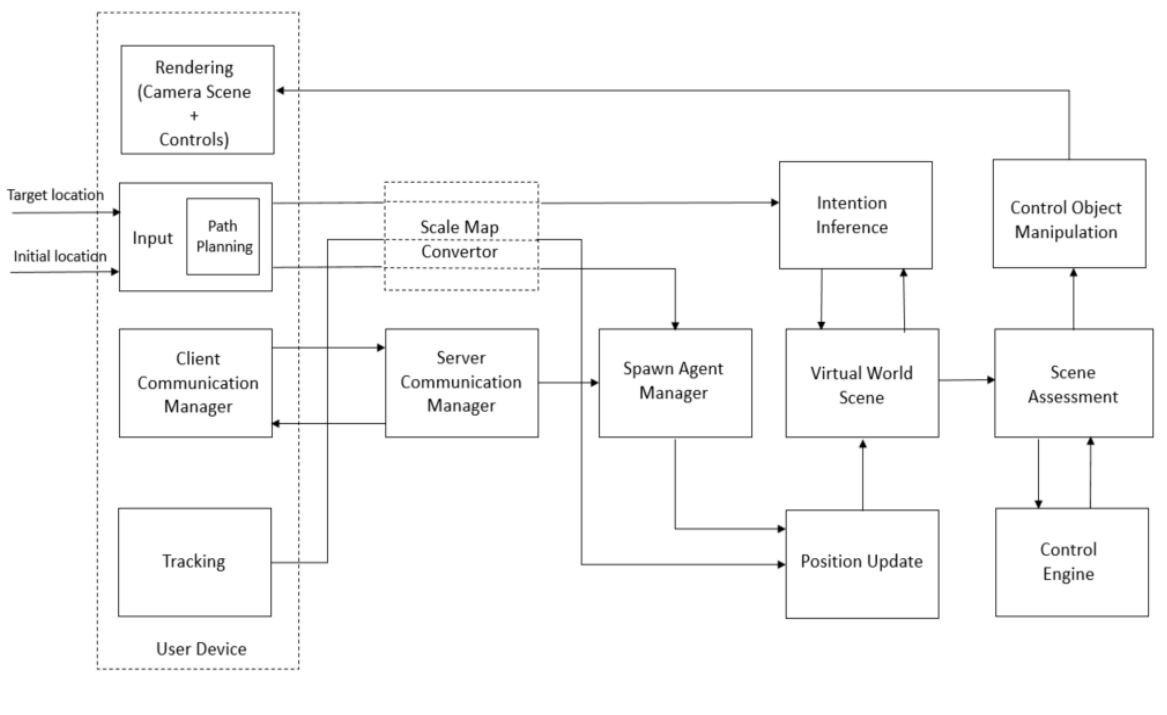
Figure 3: Components of the BCAR systems